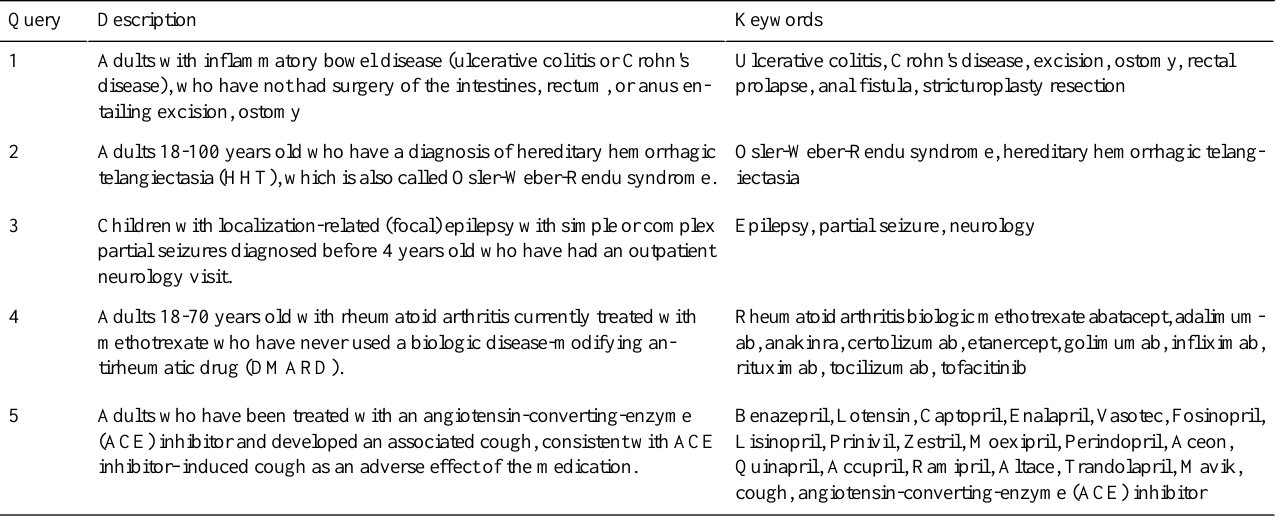
Table 2. The list of tested queries.